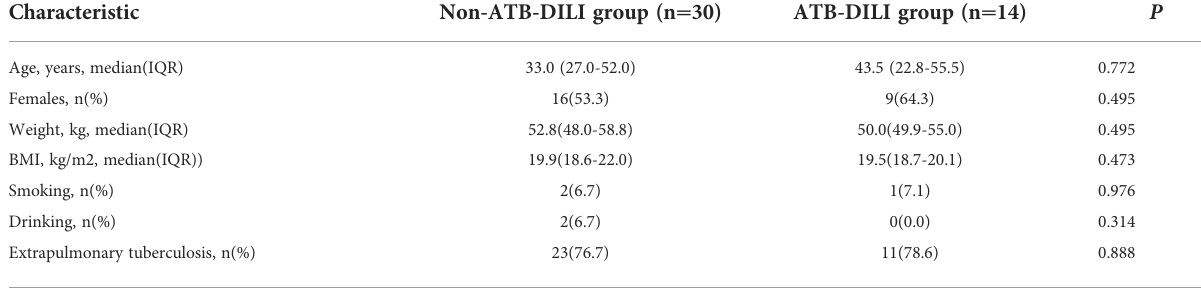
TABLE 2 Clinical characteristics of the two groups of matched patients.